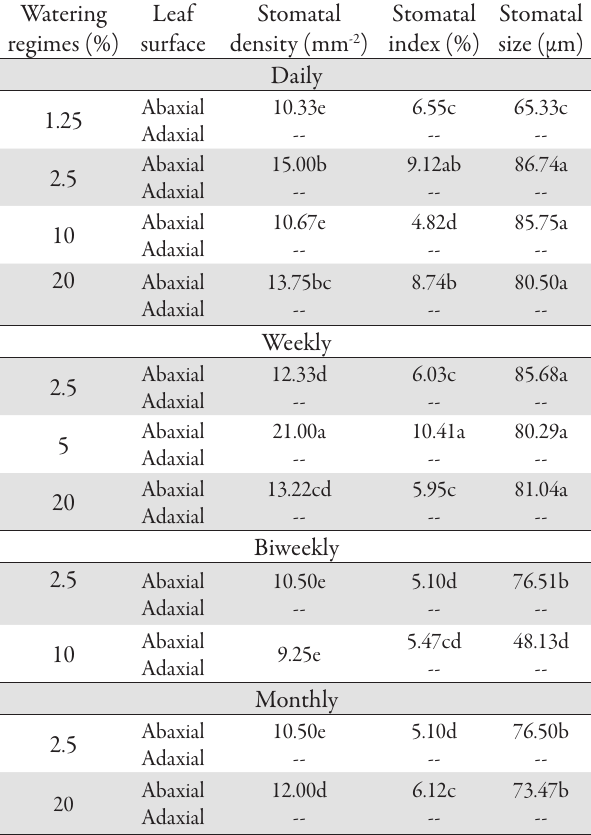
Tab. 6. Stomatal anatomy of Euphorbia milii raised with